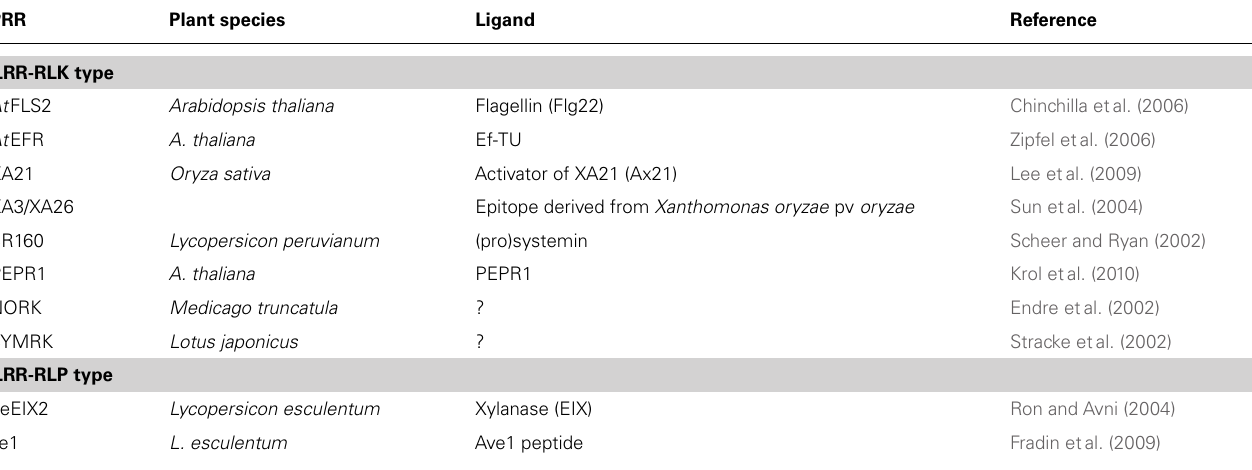
Table 1 | LRR-type PRRs involved in plant defense signaling.